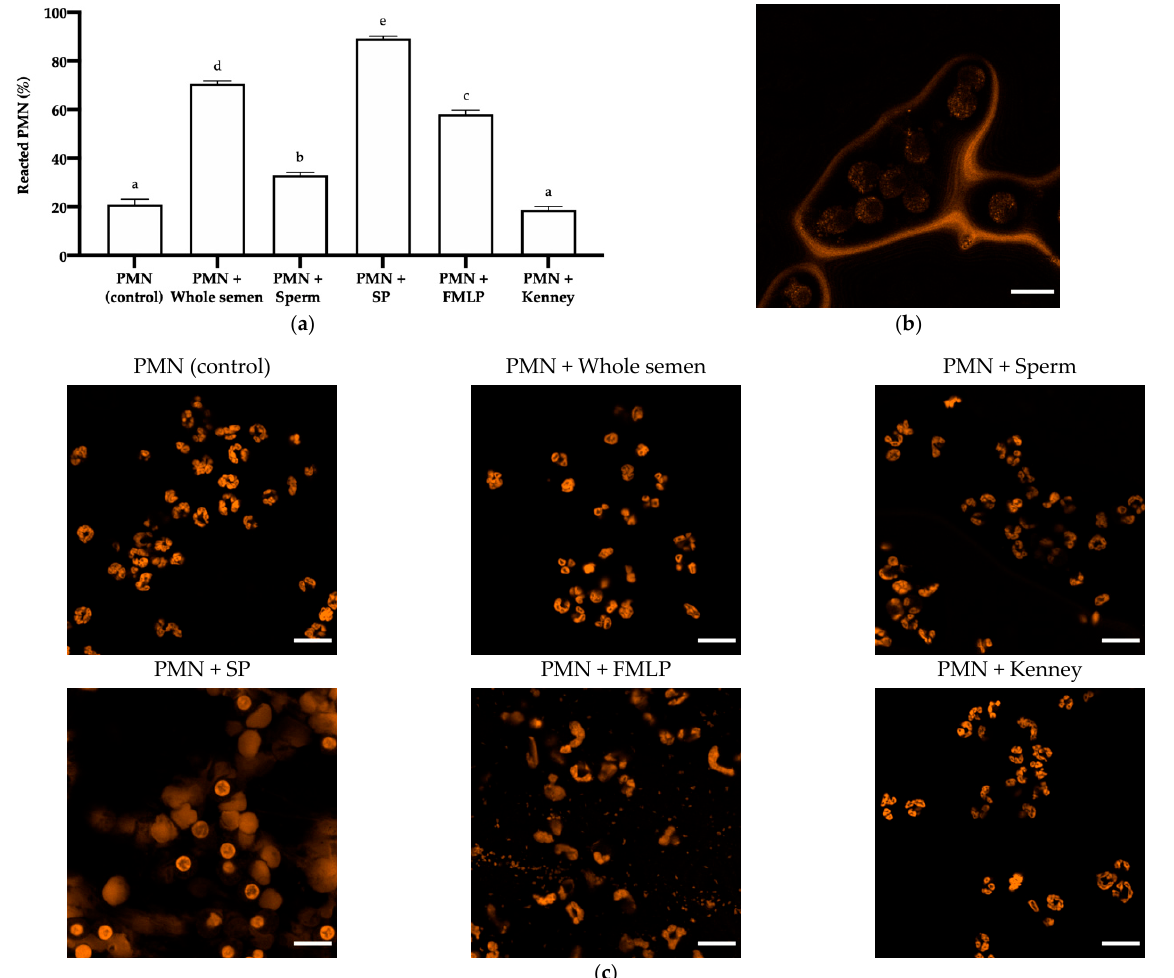
Figure 6. Activation of PMN and NETosis. ( a ) Mean ± SEM of percentages of reacted PMN in each treatment. (a–e) Different letters indicate significant differences ( p ≤ 0.05) between treatments. ( b ) NETosis of PMN with degranulation/extrusion of their molecular components. ( c ) Representative images resulting from the PMN exposure to the different treatments. Scale bar = 15 µm.